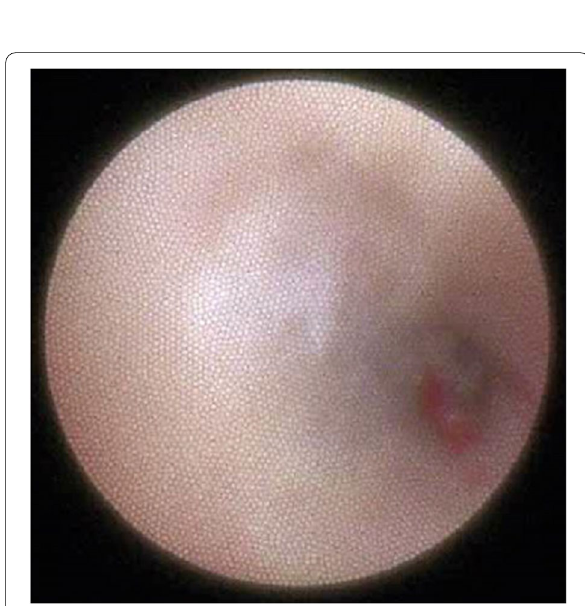
Fig. 3 Wharton’s ductal status recorded by sialendoscopy. An obvious inflammatory state with mucous plugs can be